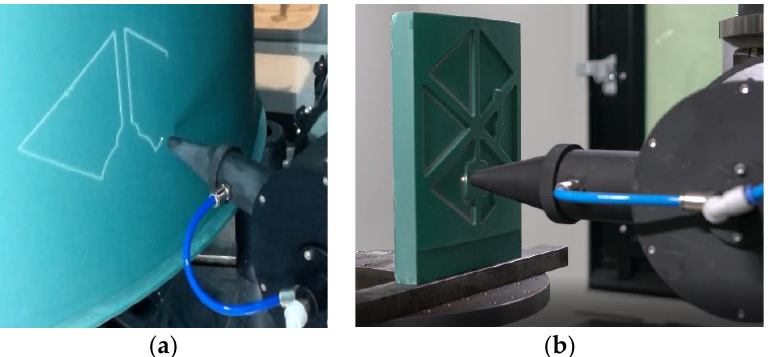
Figure 4. Laser first scribing and second scribing. ( a ) Laser first scribing on aeroengine casing parts; ( b ) Second scribing on local feature parts of aeroengine casing.